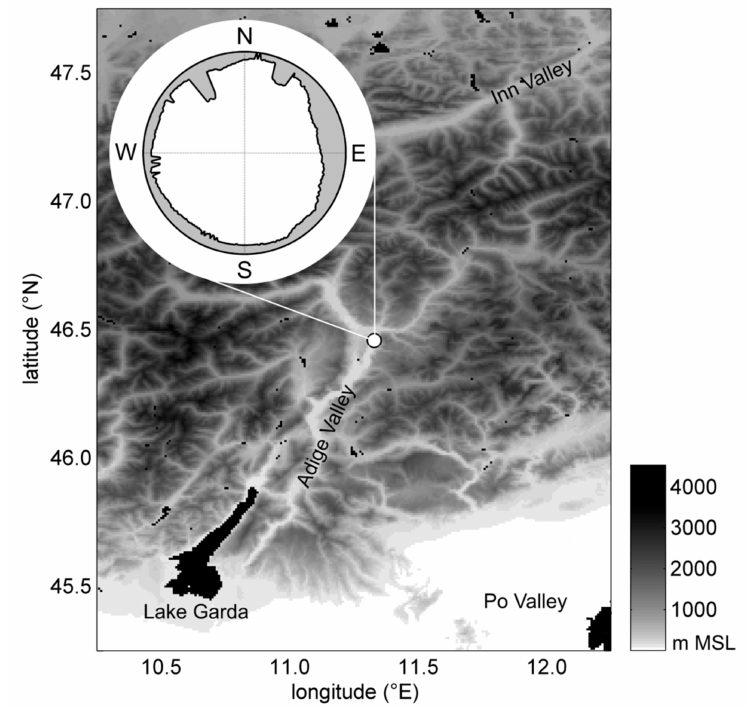
Figure 1. Location of Bolzano station (white dot) in the Eastern Alps and local orography. The horizon elevation profile for the weather station is also shown in the polar plot in the upper left